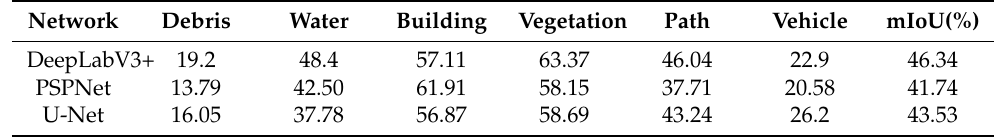
Table 4. Mean IOU results for each class on the Test Set.